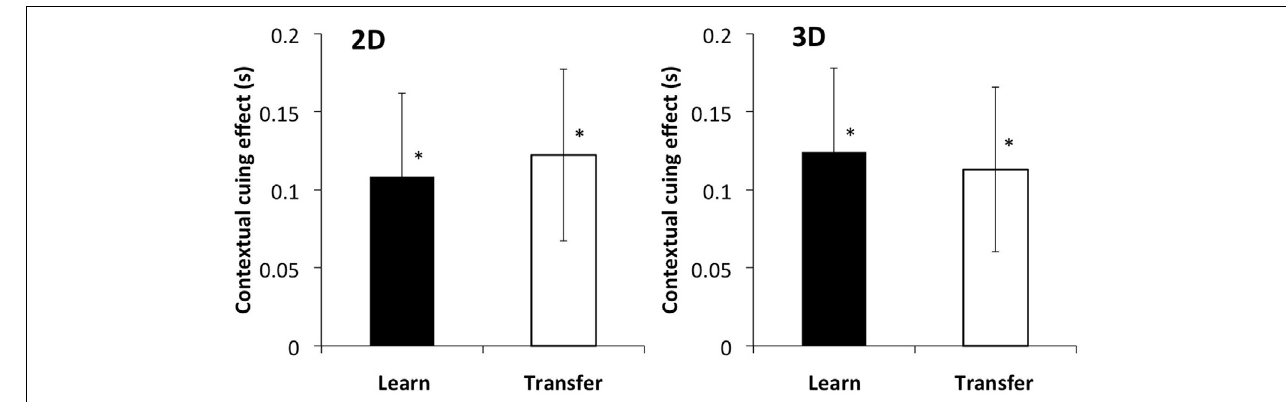
of the last two epochs of the learning phase, and the white bar shows the results of the epochs of the transfer phase. Error bars represent standard error across